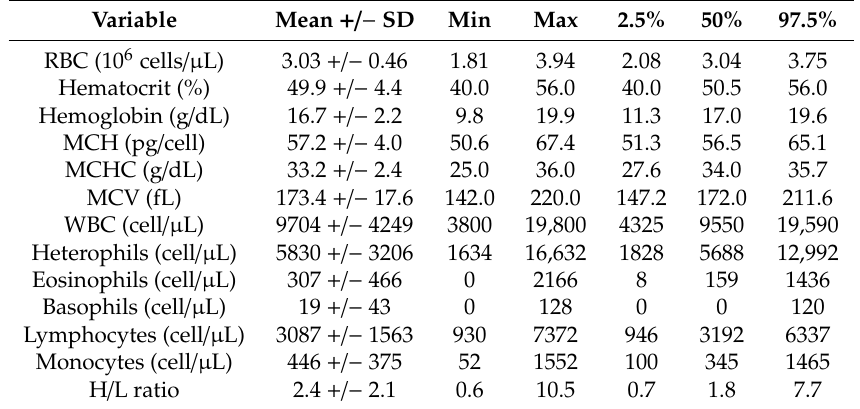
Table 1. Mean ± standard deviation, minimum and maximum values and quartiles and of hematological variables of captive black-faced ibis ( Theristicus melanopis ) (N = 22).